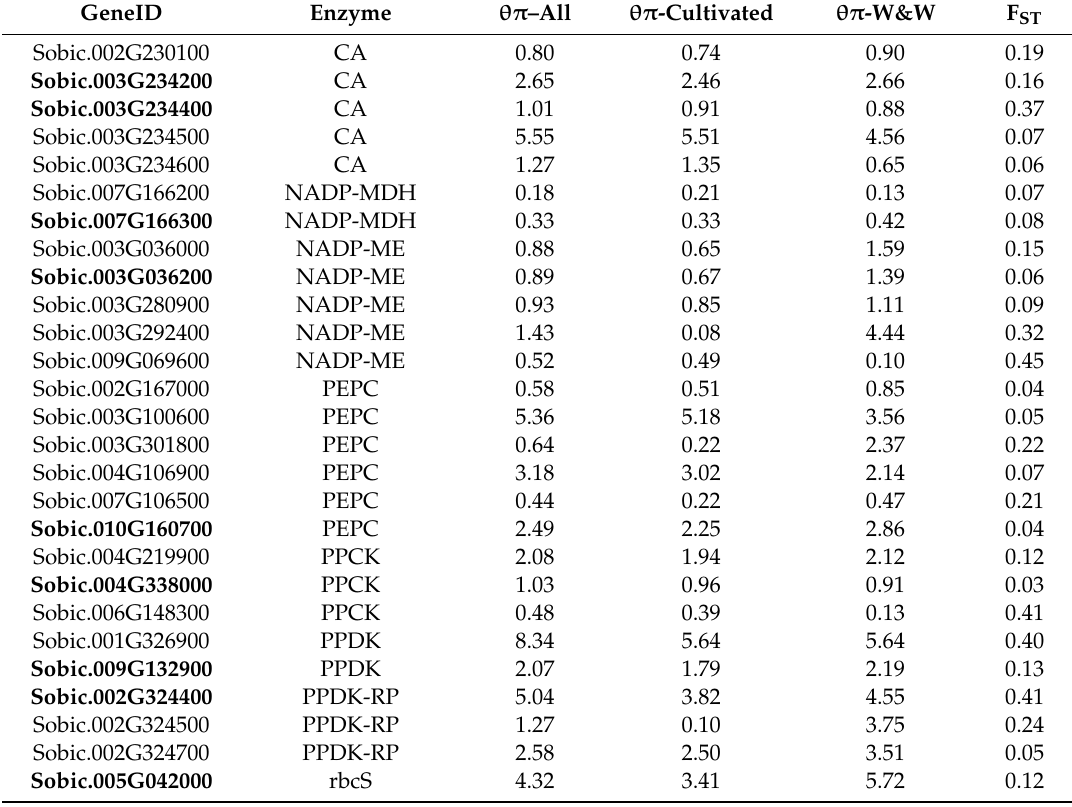
Gene ID is according to sorghum reference genome V3.1. Gene IDs in bold indicate the C4 gene versions. Enzyme: Encoded enzyme. θπ -All: Nucleotide diversity across all 48 genotypes. θπ -Cultivated: Nucleotide diversity across cultivated genotypes. θπ -W&W: Nucleotide diversity across wild and weedy genotypes. All θπ values are in unites of per kb. F ST : Fixation index between cultivated genotypes and wild and weedy